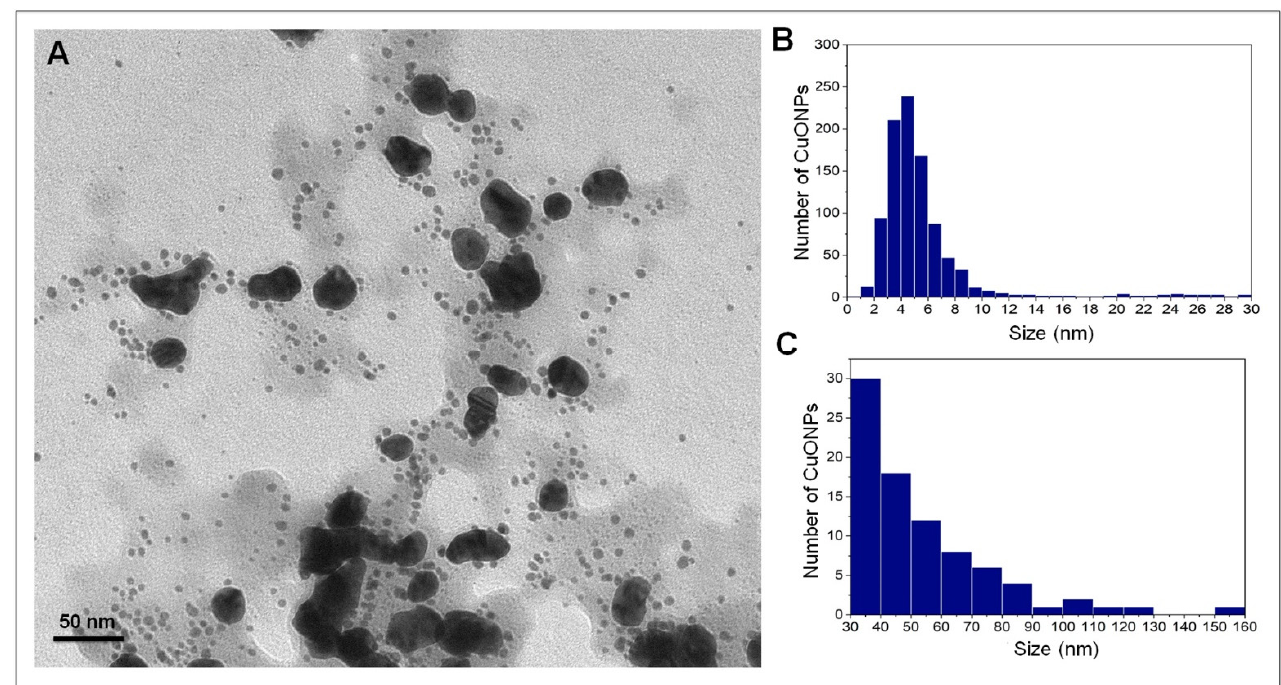
Figure 2. ( A ) Micrograph of the copper oxide nanoparticles synthesized by a biological method; ( B ) Histogram of the smallest nanoparticles; ( C ) Histogram of the largest nanoparticles. n =